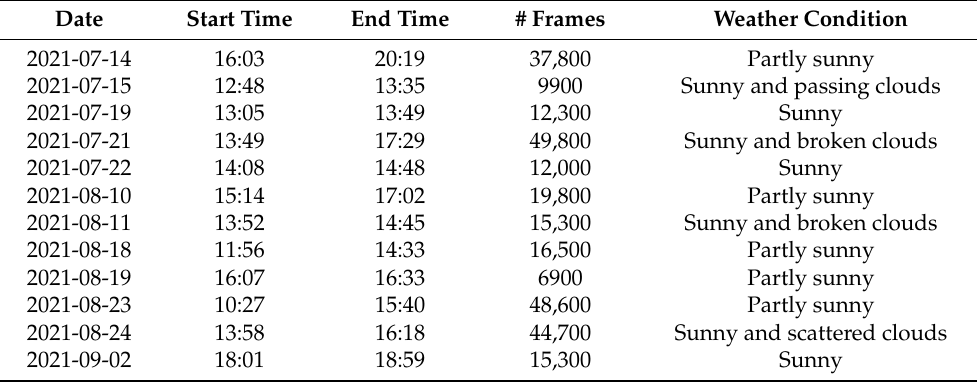
Table 1. Log of experimental trials conducted with the TurbNet-LB sensor.